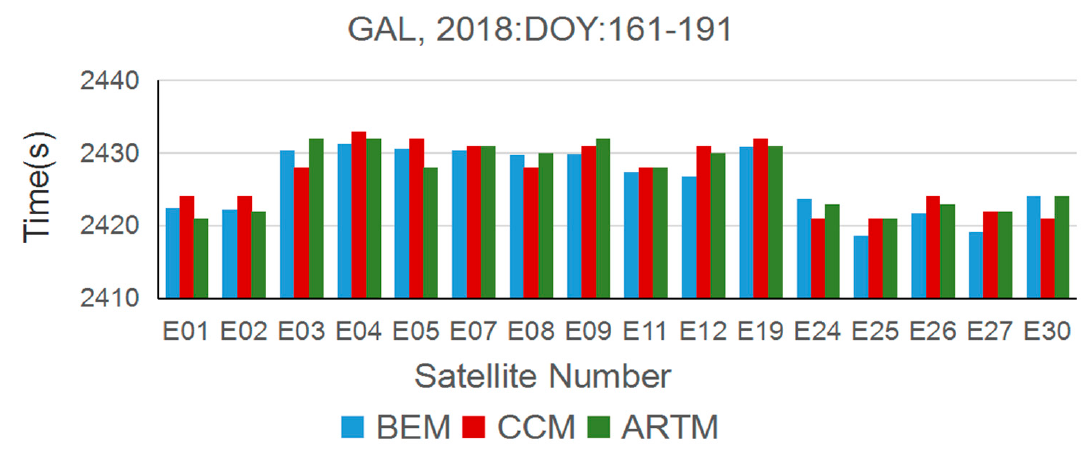
Figure 10. The mean shift time for GAL(Galileo) satellites calculated by the three methods during DOY: 161–191, 2018.